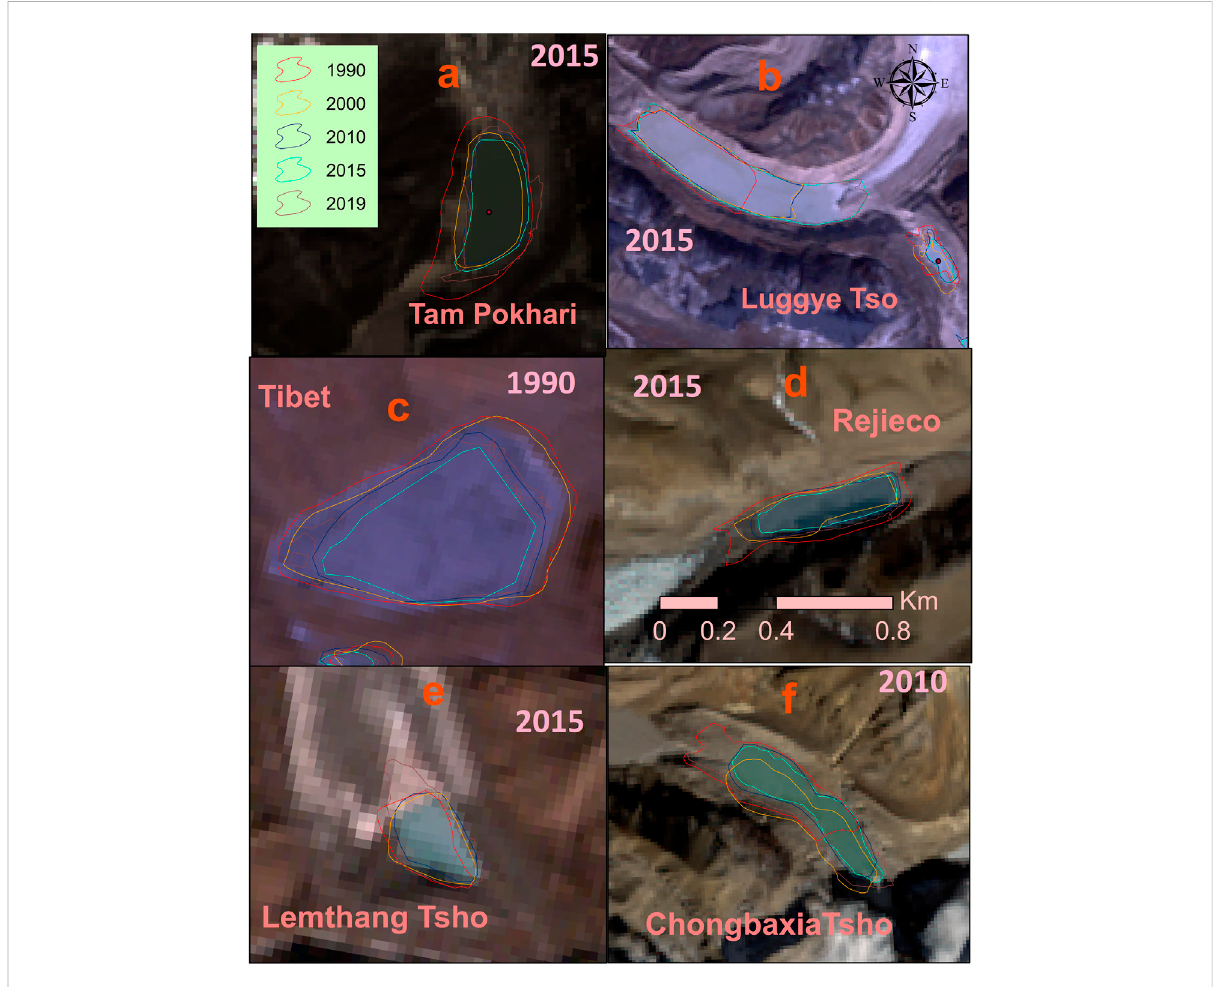
FIGURE 8 GLOF event veri fi edin a different part of the Himalaya. Here, the GLOF occurrence in different parts of the Himalaya is shown: (A) -Tam Pokhari in Everest Himalaya, (B) -Luggey Tso in Bhutan region, (C) (Tibetan plateau close to Sikkim) sdown stream of lake-f, (D) -Rejico northern slope of Sikkim, (E) - Lamthang Tso southern slope of Bhutan and (F) -Chongbaxia Tso northern slope of